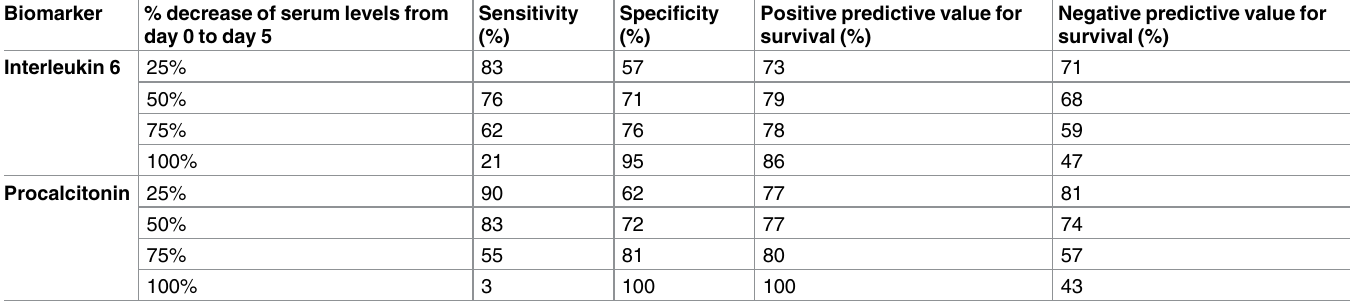
Table 6. Sensitivity and specificity of modifications in percentage of interleukin 6 or Procalcitonin in relation to survival in function of different cutoff points in patients with severesepsis/septic shock. Biomarker